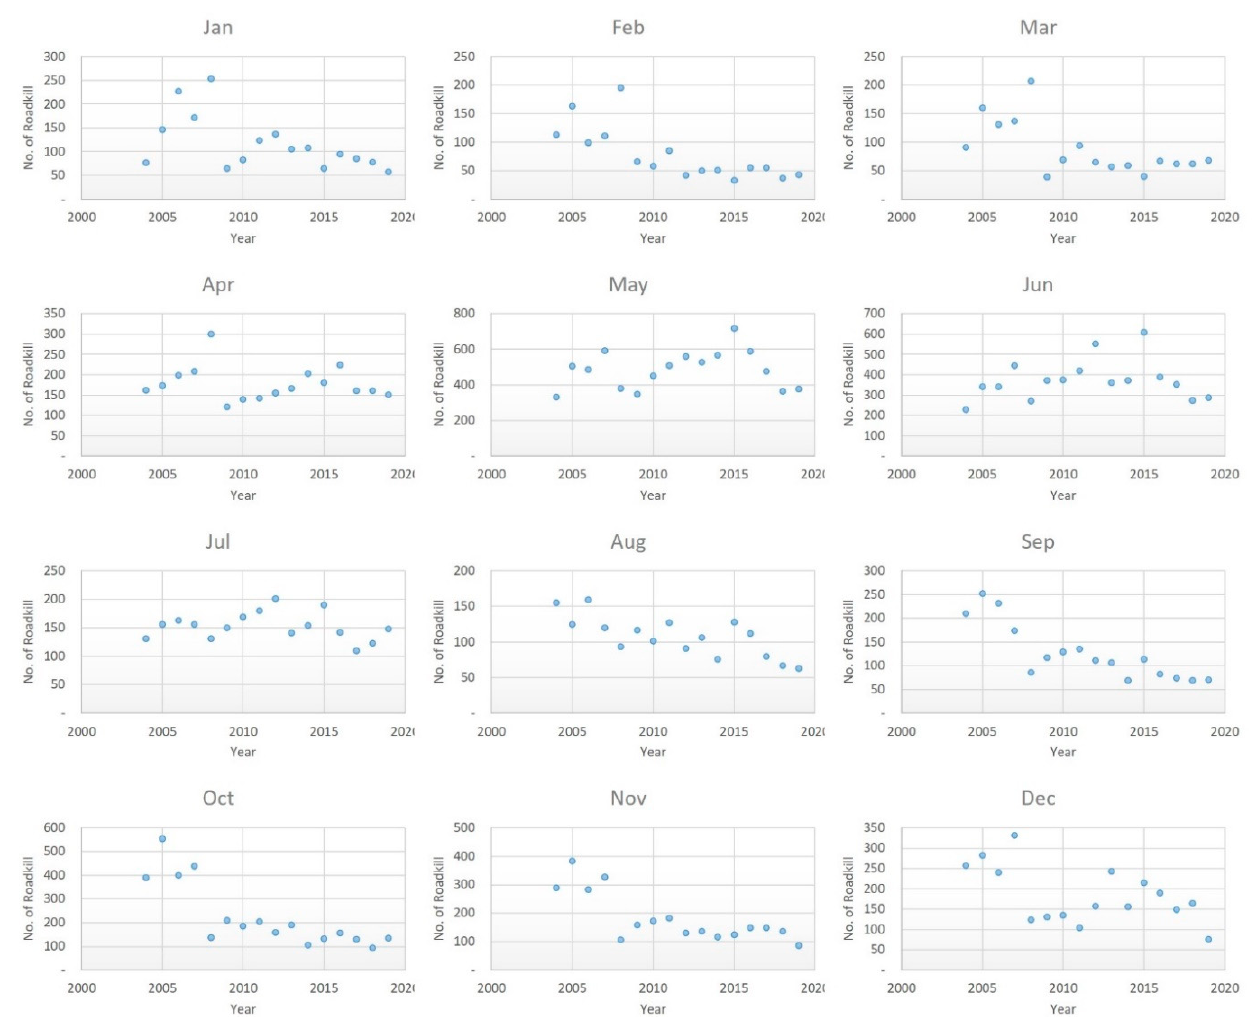
Figure 7. Distribution of expressway roadkills by month over 2004–2019. Table 4. Mann–Kendall trend analysis for month.